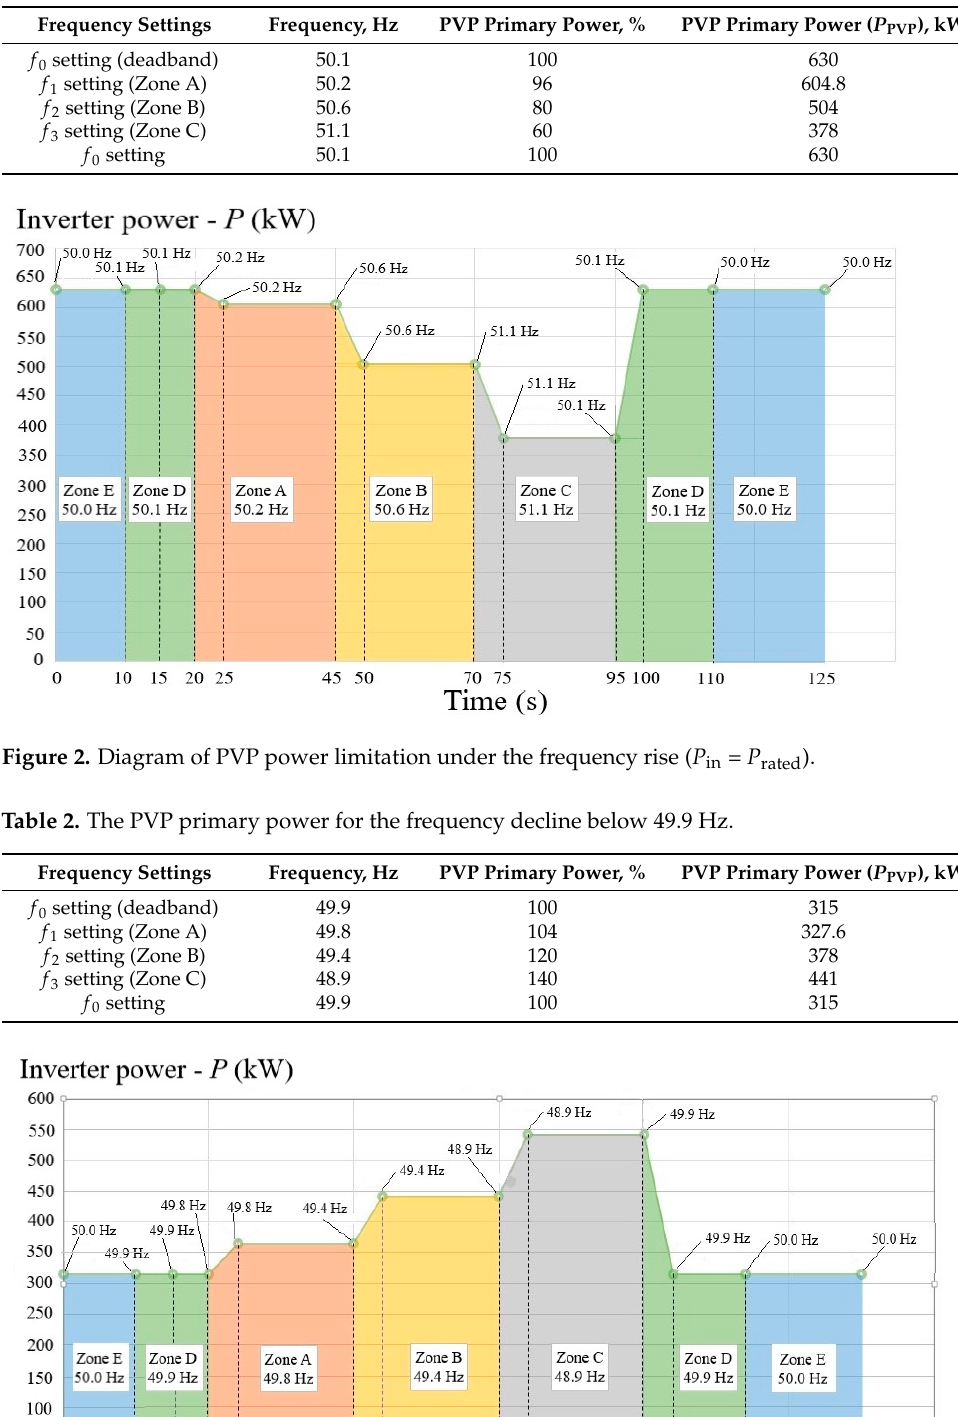
Table 1. PVP primary power for the frequency increase above 50.1 Hz.